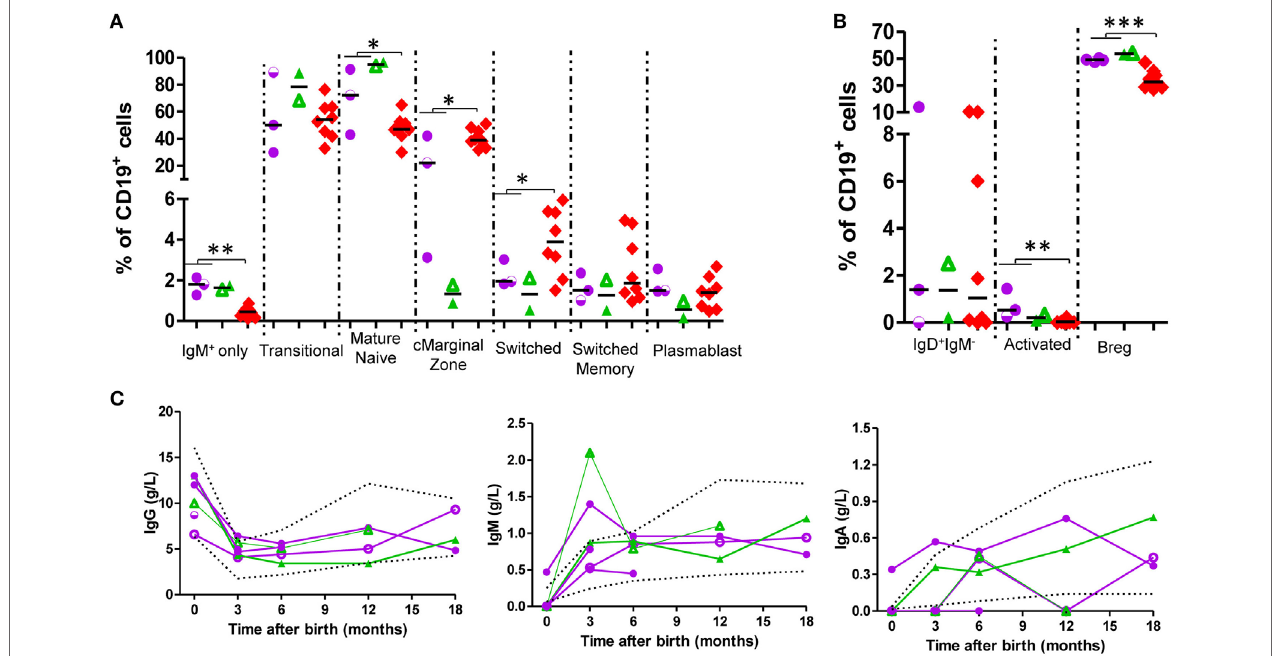
FigUre 3 | B-cells present higher levels of naïve markers and normal levels of immunoglobulins (Igs) in exposed infants. (a,B) B-cell subpopulation frequencies at birth. adalimumab (ADA)-exposed infants, n = 3; infliximab (IFX)-exposed infants, n = 2. (c) Ig production follow-up. ADA-exposed infants, n = 4; IFX-exposed infants, n = 2. Dotted lines, described reference ranges; purple circles, ADA-exposed; green triangles, IFX-exposed; red diamonds, cord blood healthy controls; empty symbols, azathioprine co-exposure; half-empty symbols: prednisone